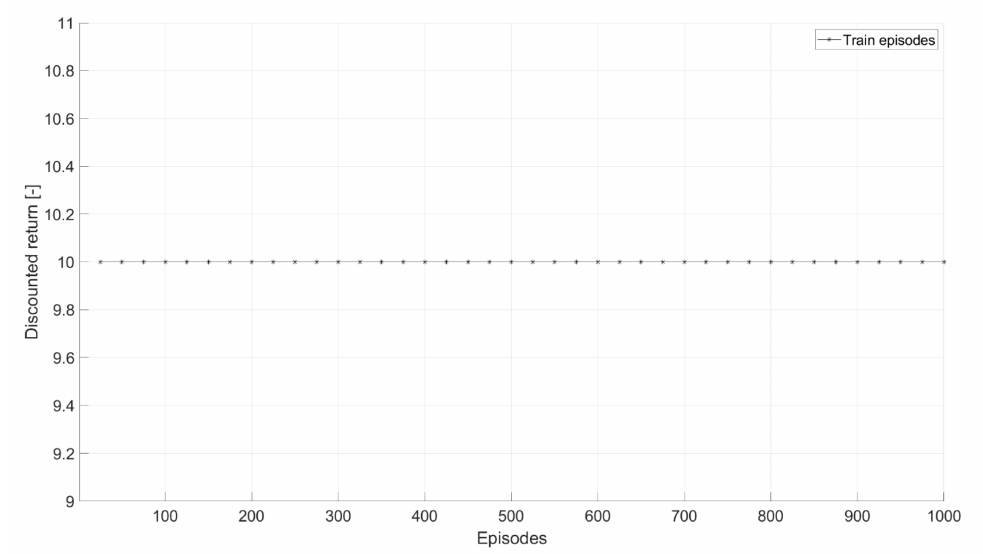
Figure 8. Effect of a null discount factor on the discounted return evaluated at the first time step of